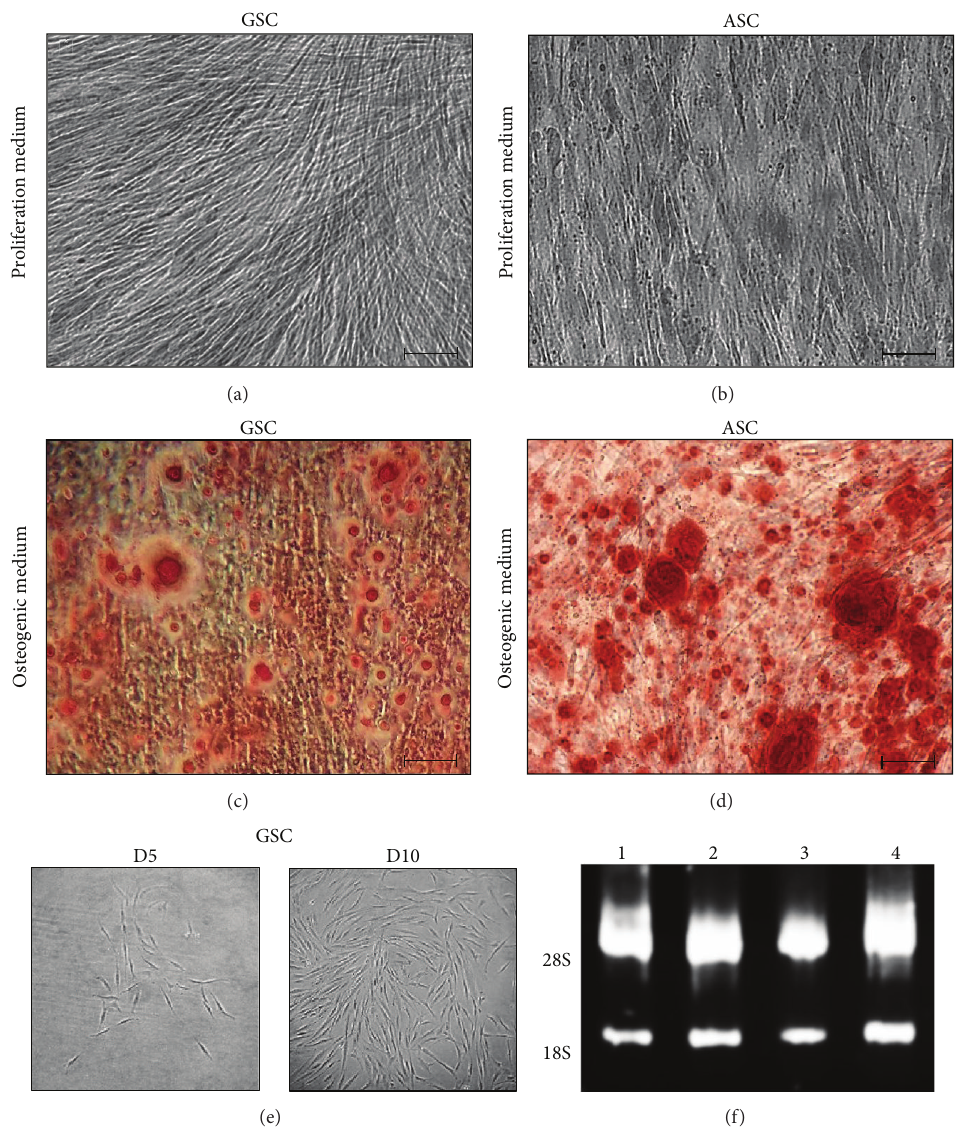
Figure 1: (a), (b), (c), and (d) Alizarin Red S Staining of GSC and ASC after 21 days of osteoblast induction. (a) and (b) GSC and ASC were cultured in proliferation medium. No differentiation is noticed. (c) and (d) GSC and ASC were cultured in osteogenic medium. Calcium mineral deposits confirmed osteoblast differentiation in both stem cells after 21 days of culture. Bar scale = 100 𝜇 m. (e) Colony forming units for GSCs. Limiting dilution of GSCs shows their ability to form colonies after 5 days of culture. (f) Agarose gel electrophoresis: total RNA quality. All RNA samples showed absence of degradation and a high degree of integrity. Upper bands: 28S, lower bands: 18S, and lanes 1 to 4: random RNA samples from GSC and